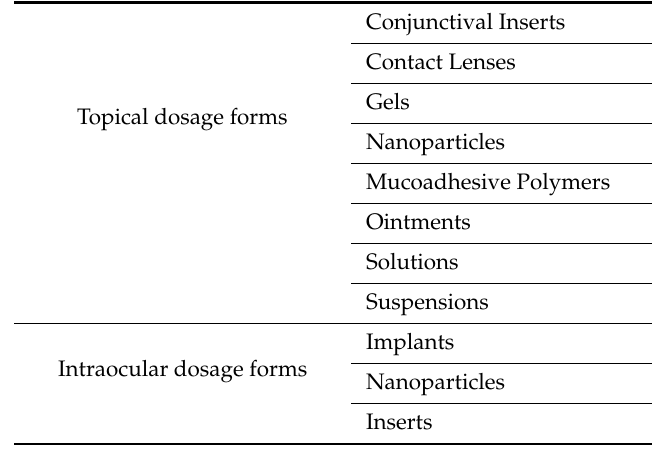
Table 1. Types of ocular drug delivery